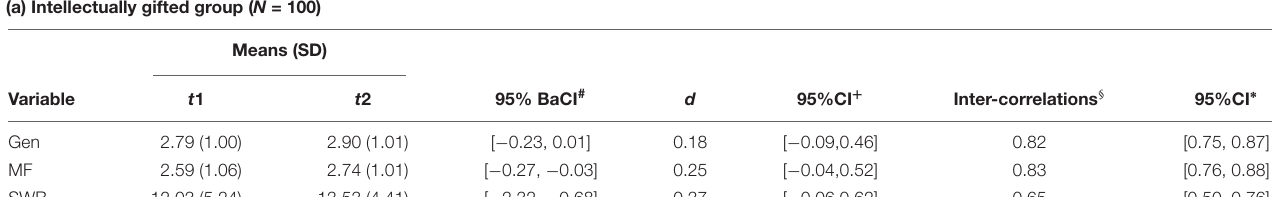
TABLE 2 | Comparison of means and inter-correlations of generativity, meaningfulness, and subjective well-being at t1 and t2 among (a) intellectually gifted and (b) high academic achievers. (a) Intellectually gifted group ( N = 100)